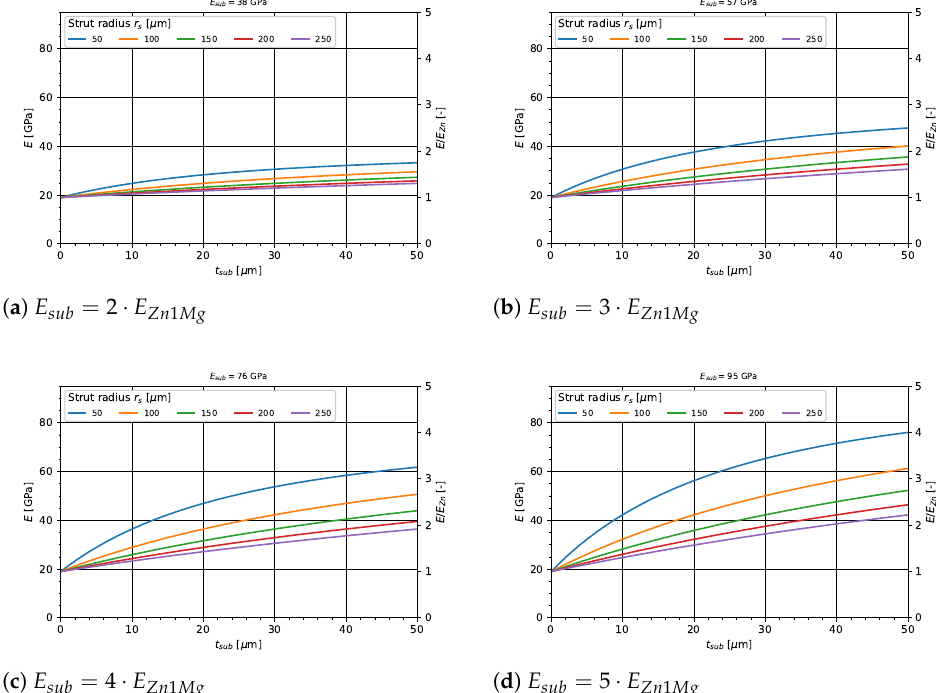
Figure 7. Analytical calculation of the axial stiffness of a single composite strut for varying parameters of the substrate